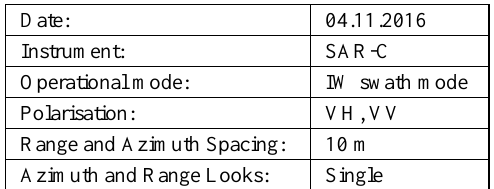
Table 2. Features of the S1A level-1 product GRD